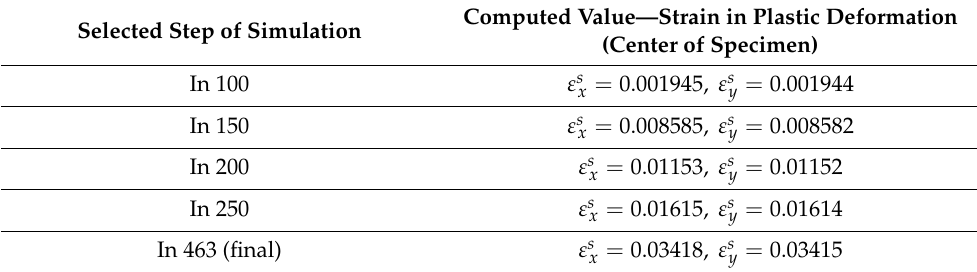
Table 1. Table of numerically computed values of strain in some selected steps.